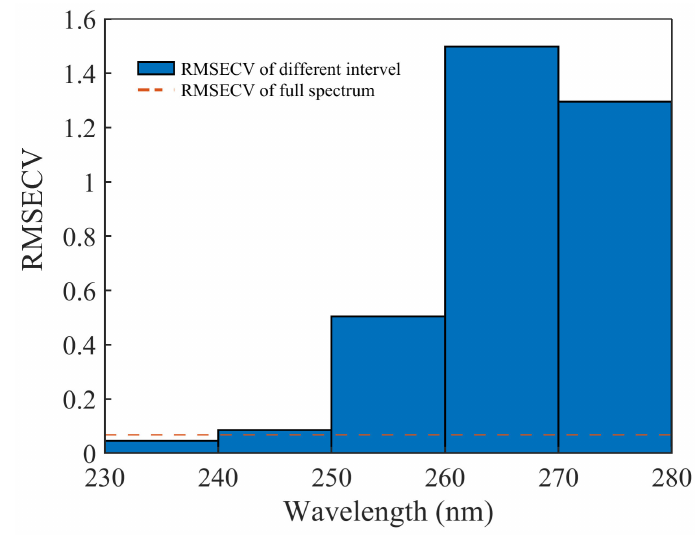
Figure 4. Interval optimization by interval-partial-least-squares method.